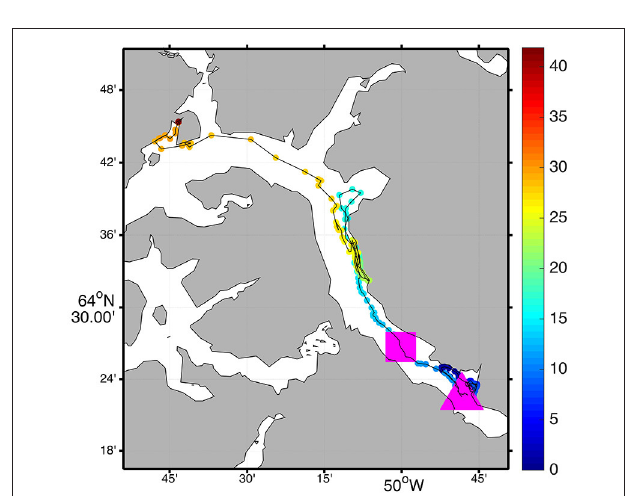
FIGURE 6 | A trajectory of an EXITE beacon initially deployed at the large pink triangle. Locations are color-coded according to time, in days, since deployment. Every 4th measurement is shown for clarity. The location where the critical acceleration was exceeded is indicated by the large pink square.